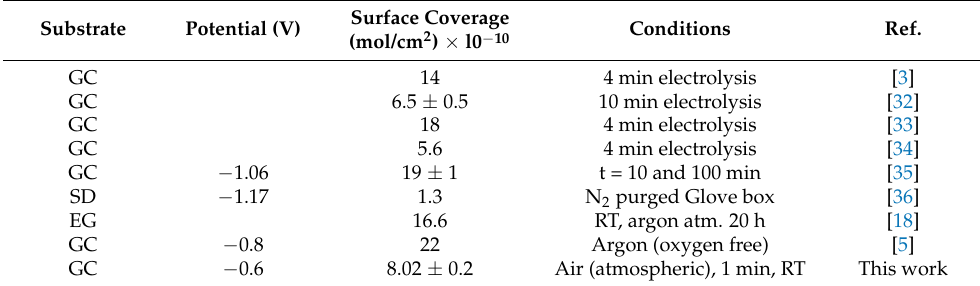
Table 1. 4-p-nitrophenyl surface coverage on carbon-based